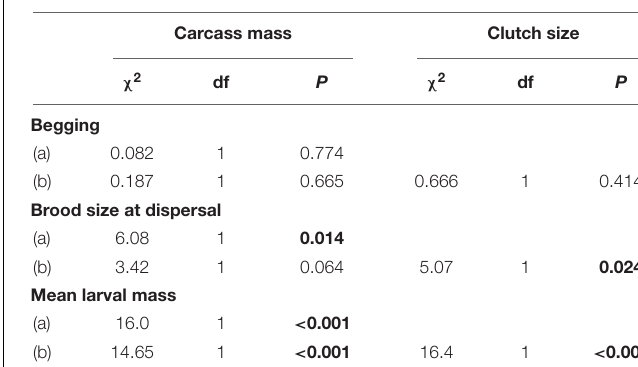
TABLE 2 | Effects of carcass mass on larval begging, brood size at dispersal, and mean larval mass at dispersal when clutch size is excluded (a) and included (b) in the